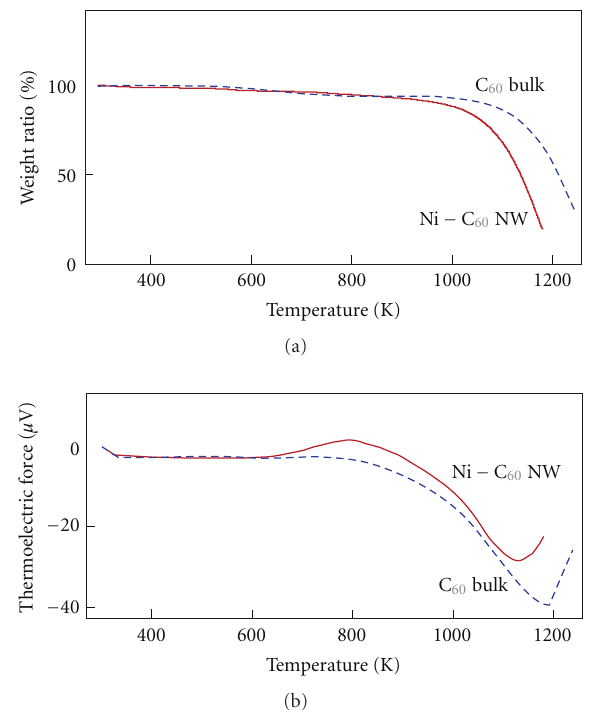
Figure 3: (a) Thermogravimetric analysis curves and (b) di ff eren- tial thermal analysis curves of Ni-doped nanowhiskers (specimen A, solid lines) and pure C 60 bulk (broken lines) in nitrogen